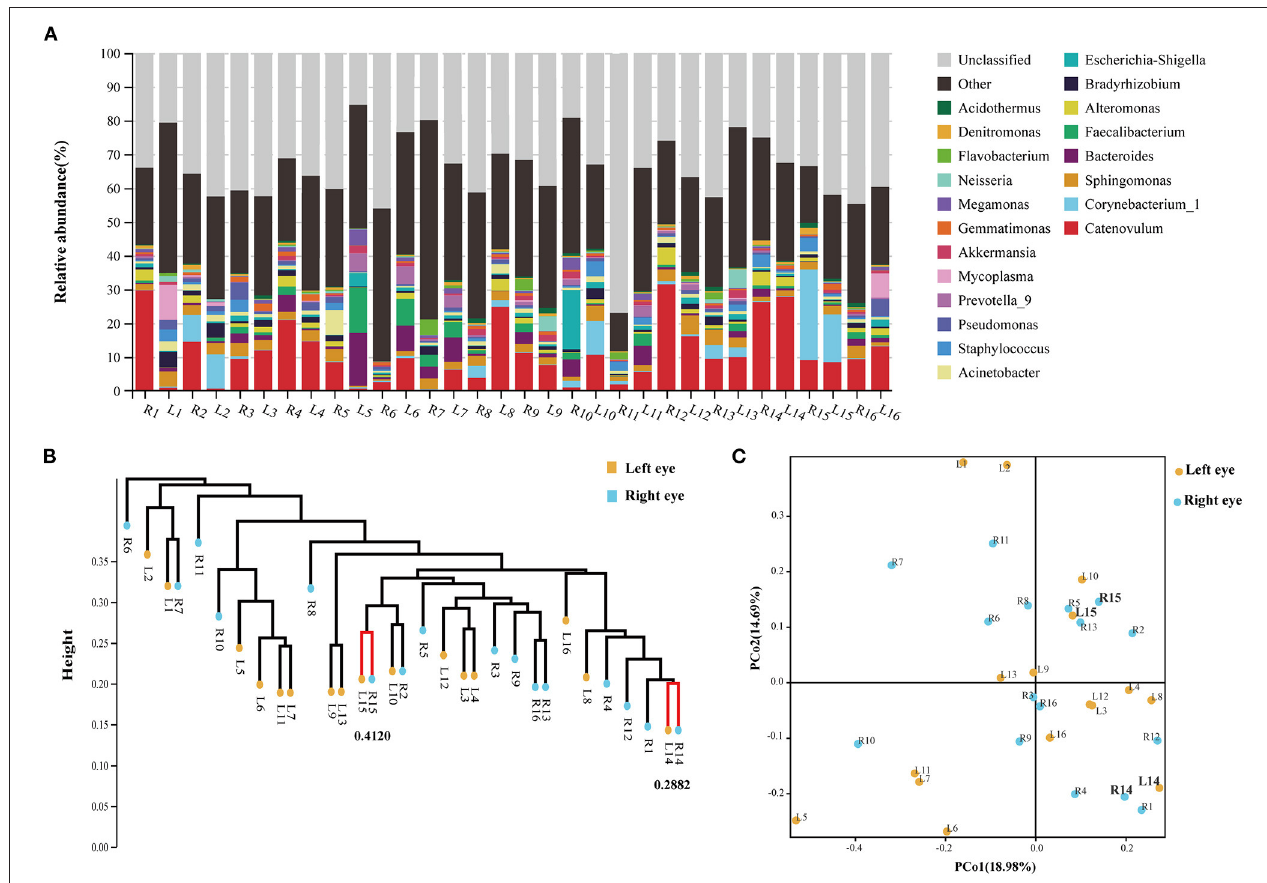
FIGURE 2 | Analysis of composition and dissimilarity of bacterial community between eyes within individual at baseline. (A) Stacking map of abundance of bacteria at baseline. 16S rRNA gene sequences were classified into genus levels. (B) Unweighted pair group method with arithmetic mean analysis (UPGMA) of all samples at baseline. (C) PCoA analysis between right (R) and left (L)